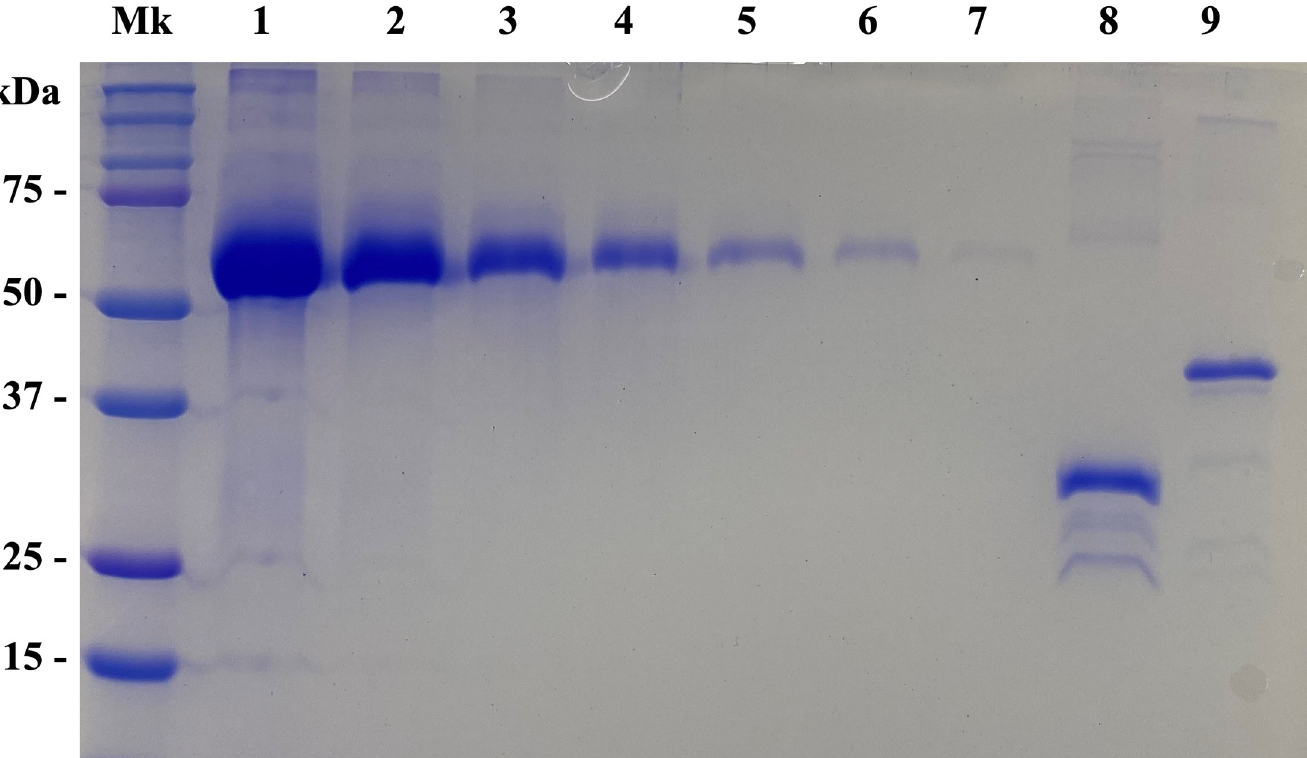
Fig 1. Integrity and concentration of the recombinant proteins. Lane Mk: Biorad Precision plus protein dual color marker standards. Lanes 1–7: Bovine serum albumin (BSA) protein standard curve in decreasing concentrations. Lane 1: 1 mg /mL. Lane 2: 0.5 mg /mL. Lane 3: 0.25 mg /mL. Lane 4:0.125 mg /mL Lane 5: 0.062 mg /mL. Lane 6: 0.031 mg /mL Lane 7: 0.015 mg /mL. Lane 8: 1/20 dilution of recombinant protein T24H. Lane 9: undiluted recombinant protein